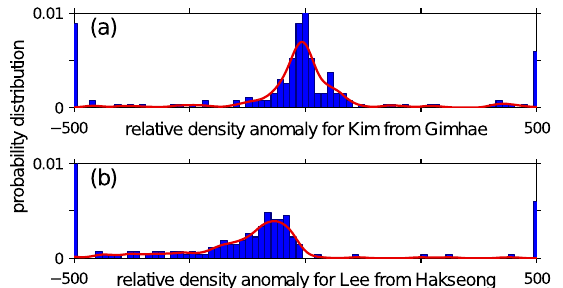
FIG. 16. (a) MRS [84] of the population-flow network for (a) Kim from Gimhae and (b) Lee from Hakseong. In panel (a), red lines indicate directed edges towards Seoul, and blue lines indicate directed edges towards other regions. In panel (b), we show directed edges towards Ulsan in purple and directed edges towards other regions in blue.